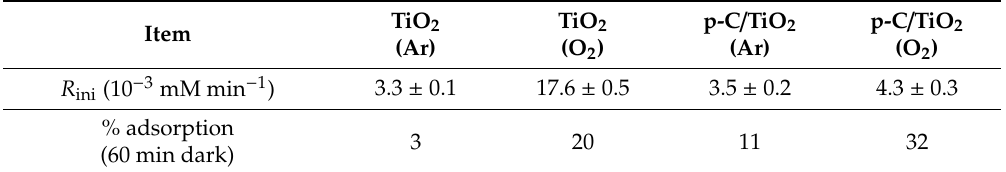
Table 2. Extent of adsorption and initial rates of photodegradation of phenol (1.0 mM; pH 3.0) on pristine TiO 2 and on p-C / TiO 2 in aqueous media under an inert atmosphere (Ar) and in the presence of O 2 exposed to UV irradiation.